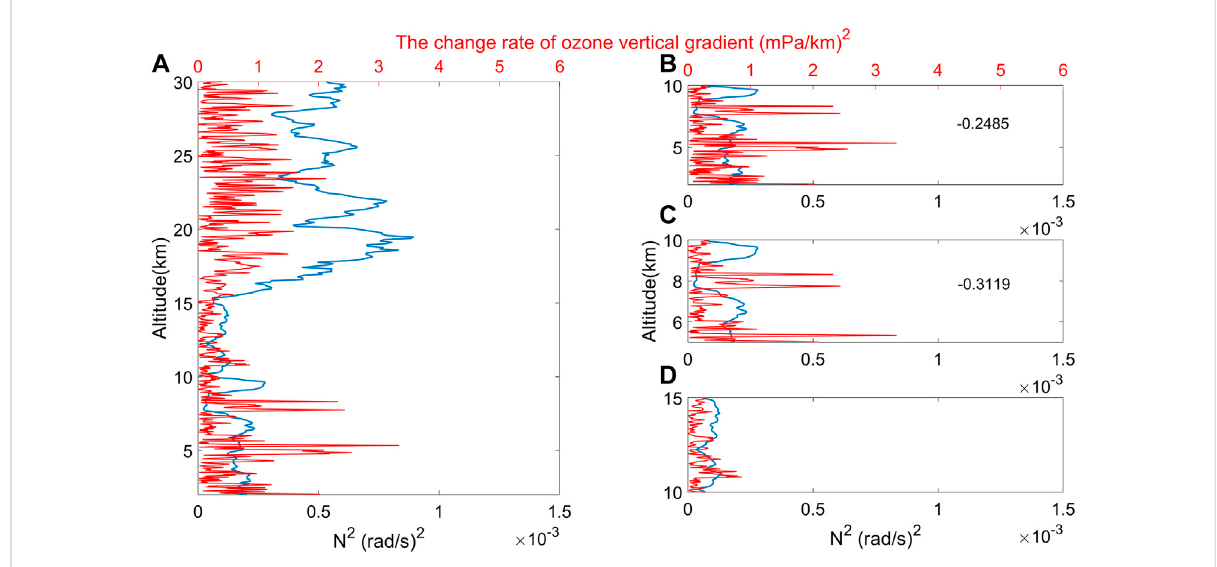
FIGURE 8 Distributions of N 2 (blue line) and the change rates of the ozone gradient (red line) at different altitudes on 15 October 2021: (A) 2 – 30 km, (B) 2 – 10 km, (C) 5 – 10 km and (D) 10 – 15 km.